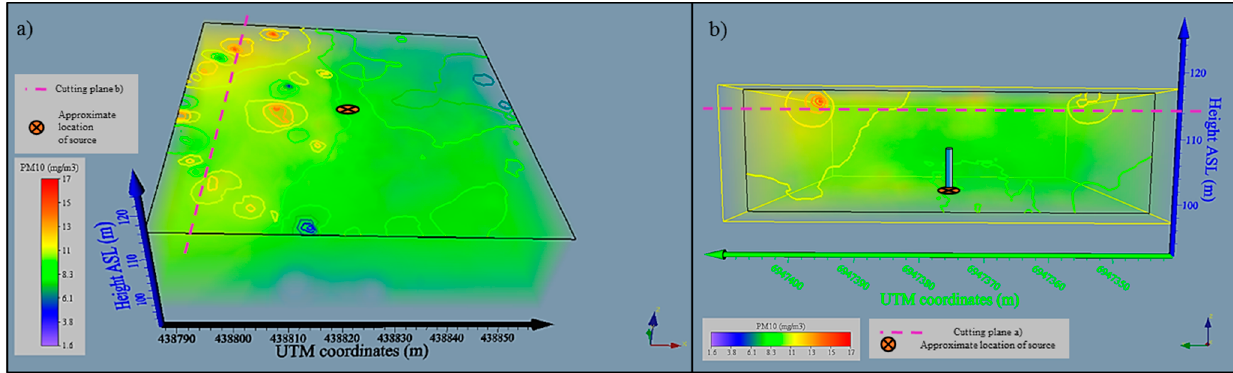
Figure 17. Volume rendering and contour plots created with quadcopter dataset ( a ) top view 18 m above ground level (from the East) and ( b ) side view 30 m away from the source (from the